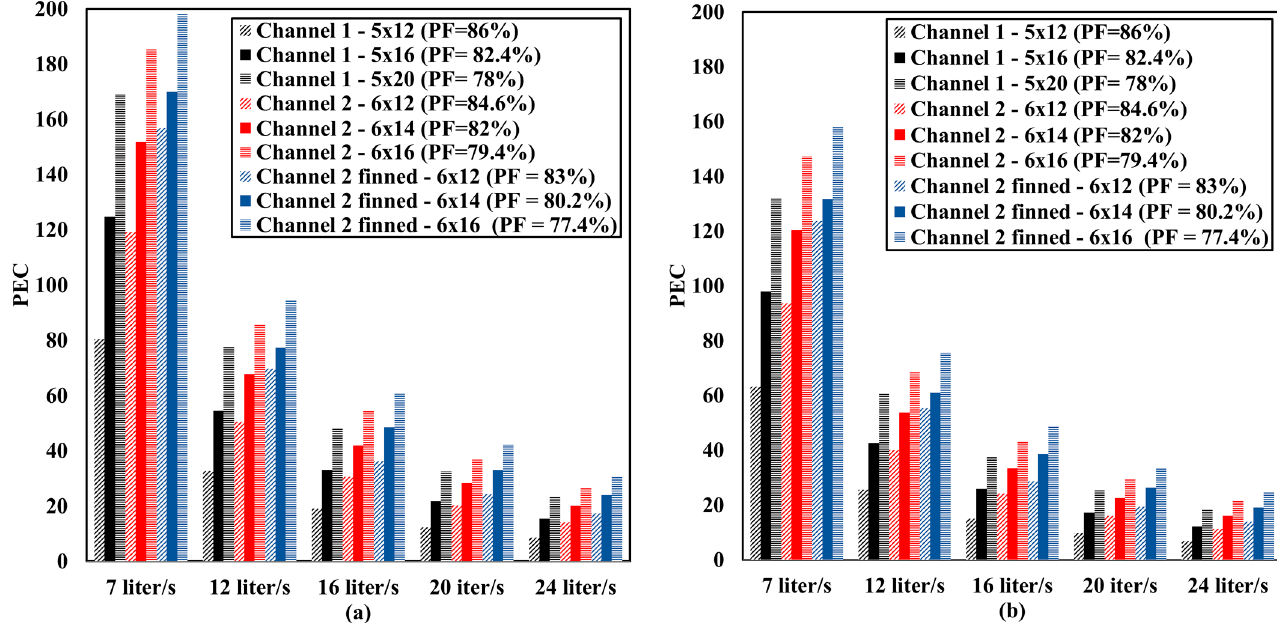
Figure 13. PEC of the compact component as a function of total air flow rate: ( a ) melting—Tin = 30 °C, ( b ) solidification— Tin = 15 °C.